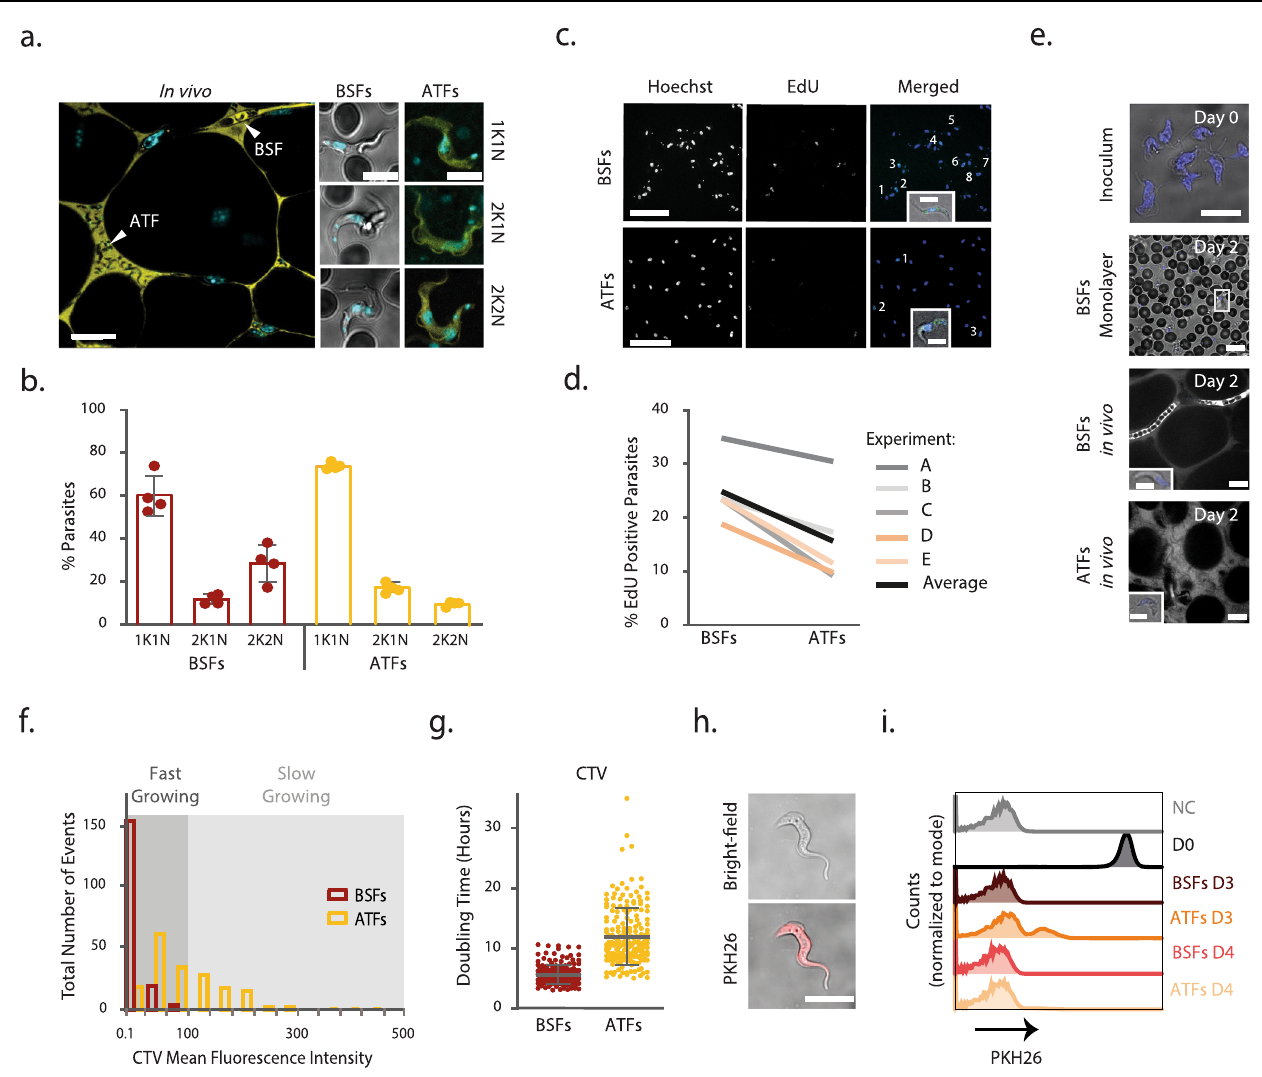
Fig. 4 | Parasite proliferation in blood and gonadal adipose tissue. a Cell-cycle analysisassayedbythenumberofKinetoplasts(K)andNuclei(N)inBSFsandATFs Lister427parasitesfrommiceinfectedfor5days( n =4independentexperiments). Left side: Representative image of in vivo microscopy of the adipose tissue and a vessel (scale bar, 20 µ m); Right side: representative images of the three parasites analyzed ona monolayer (BSFs) andin vivo (ATFs)(Hoechst, blue;scale bar,5 µ m). b PercentageofBSFs(redcircles,bars)andATFs(yellowcircles,bars)ineachstage of the cell cycle. More than 800 cells per condition. Error bars represent the averageandthestandarddeviation. c ExvivomicroscopyimagesofLister427BSFs and ATFs labeled with EdU (green) and Hoechst (blue) ( n =5 independent experi- ments) (scale bar, 20 µ m). Insets: representative images of labeled parasites (scale bar, 5 µ m). d Percentage of EdU positive BSFs and ATFs. More than 300 cells per condition. Generalized linear mixed-effects model [GLMER], p =0.00031. e Representative images of ex vivo microscopy of the inoculum parasites and a monolayerofBSFsstainedwithCTVandinvivomicroscopyofATFsandBSFs(scale